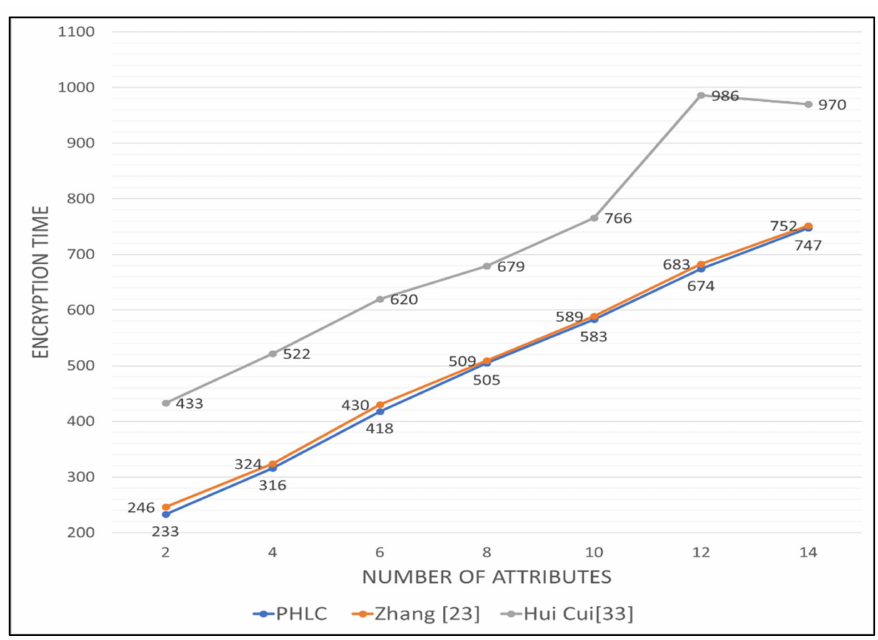
Figure 10. Encryption